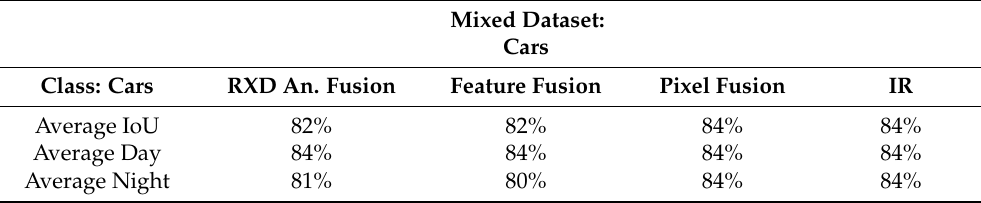
Table 5. IoU scores for cars’ classification of networks trained with Mixed DS of the different processes. Average IoU score is for all images in the dataset; average day and average night separately sum the relative score for daylight images and for nightlight images out of the mixed DS, respectively. Scores are calculated in relation to GT annotations.